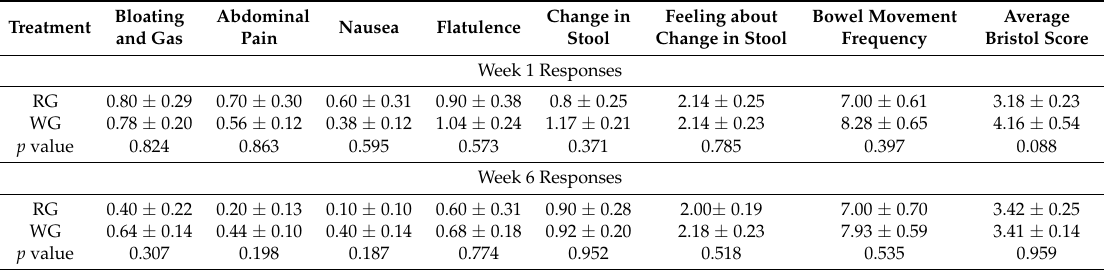
Table 5. GI symptoms reported at Weeks 1 and 6 of the refined grain (RG) ( n = 10) and whole grain (WG) ( n = 27) interventions 1,2